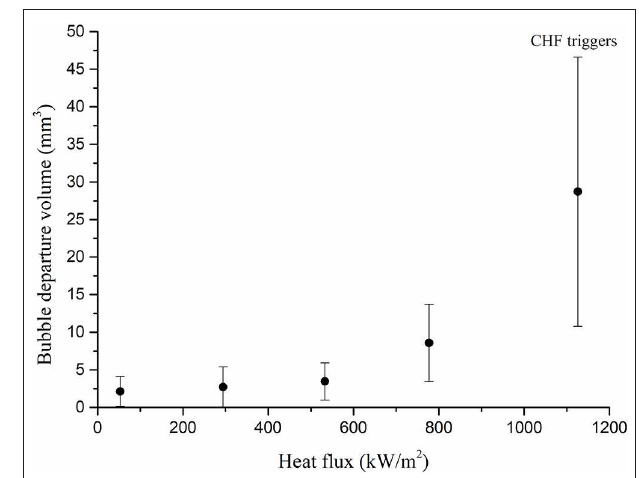
FIGURE 8 | Hydrogen departure volume according to the current density. FIGURE 9 | Bubble departure volume according to the heat flux (Yeom et al.,